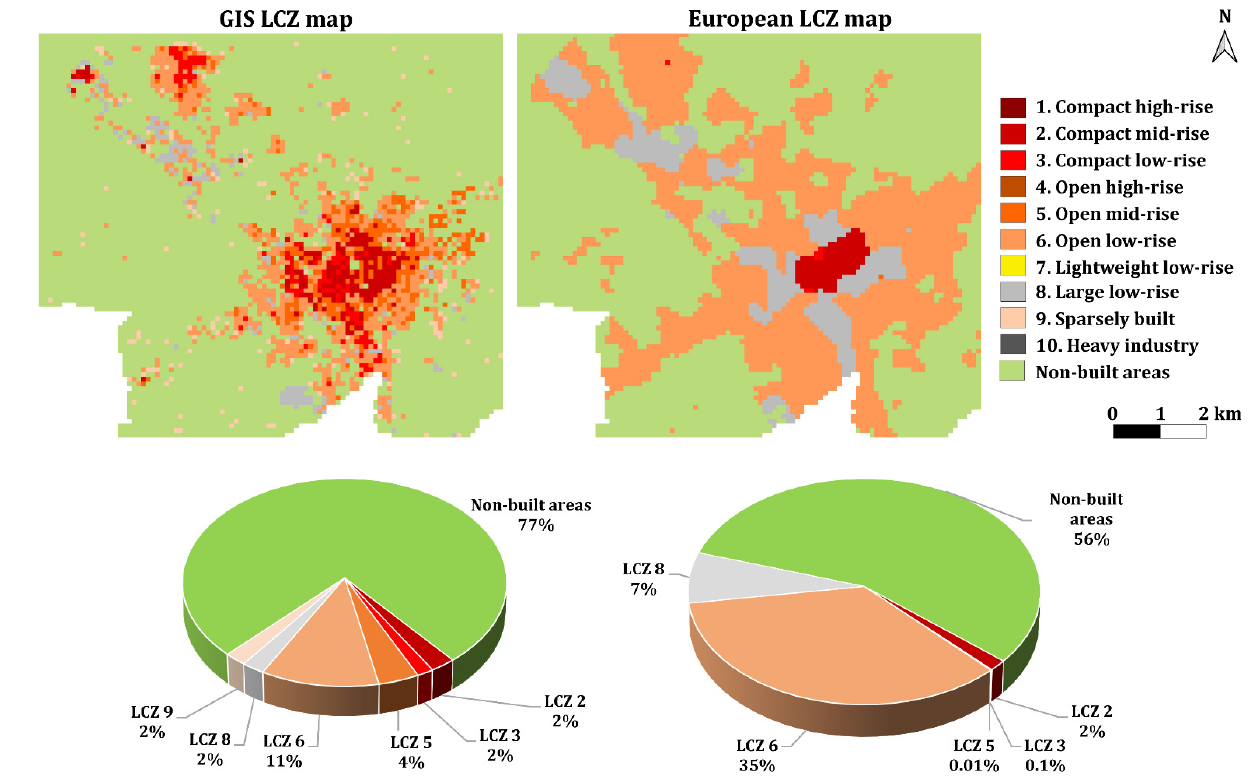
Figure 6. LCZ map obtained using morphological parameters (LCZ GIS map) ( left ) European LCZ map [40] ( right ) for the region of Lecce, with indication of percentage area for the different LCZ classes.